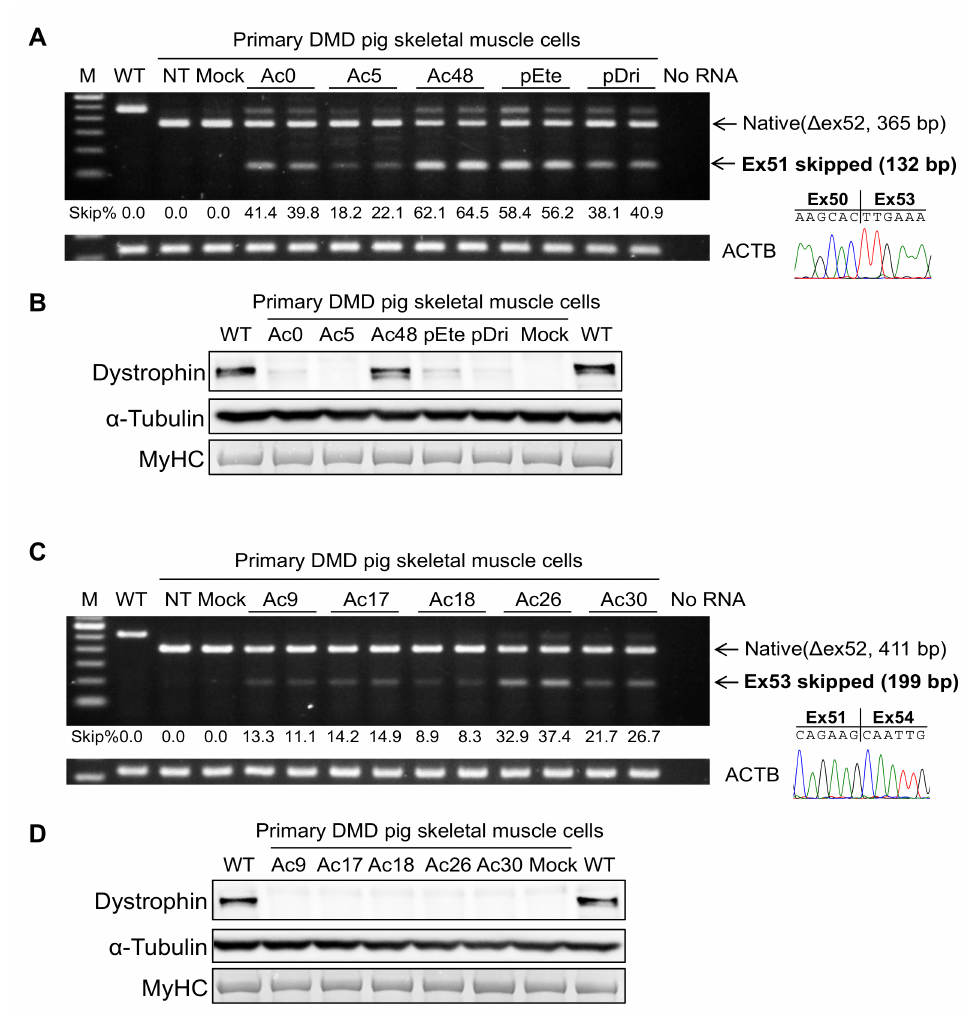
Figure 6. The feasibility of DMD exon 51 or 53 skipping in the DMD ex52del pig skeletal muscle cells in vitro. Exon 51 skipping efficiency ( A ) and expression levels of rescued dystrophin protein ( B ) were analyzed in primary DMD pig muscle cells treated with 10 µ M PMOs and 6 µ M transfection agent, Endo-Porter (the culture condition is shown in Figure S2A). The efficiency of exon 53 skipping using pig PMOs was also tested in primary DMD pig cells ( C ), but no dystrophin was detected on Western blotting ( D ). pEte, the pig version PMO of FDA-approved eteplirsen; pDri, the pig version PMO of drisapersen previously tested in a clinical trial as 2 (cid:48) -O-methyl phosphorothioate oligonucleotides. WT, wild-type; NT, non-treated; Mock, 31-mer negative control PMO. Alpha-tubulin and MyHC were used as a loading control and marker of myogenic differentiation, respectively. Representative results from three independent experiments using two DMD pig cell lines derived from pigs with IDs 9594 and 9595 are